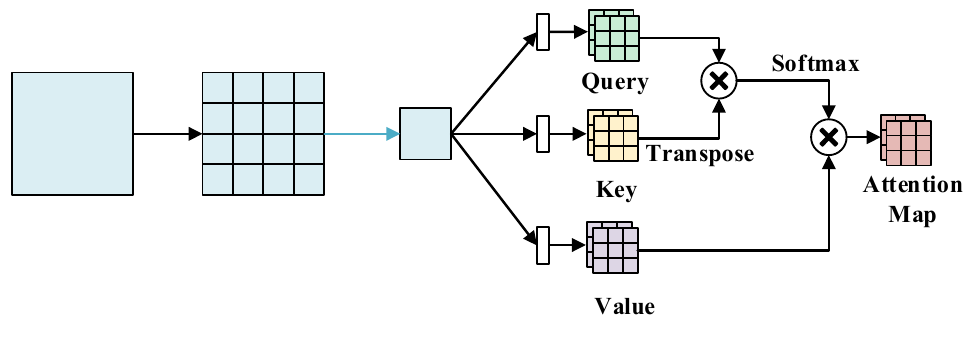
Figure 3. The structure of the PTM.